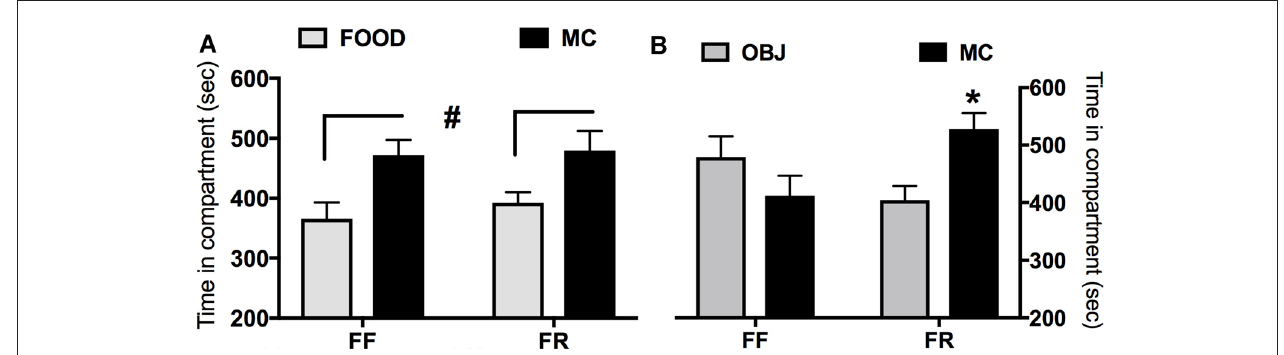
FIGURE 4 | Effects of restricted feeding (FR) on conditioned preference (seconds spent in compartment ± SEM) for a context paired with milk chocolate (MC) in different experimental conditions. (A) Preference for the MC-paired compartment vs. the compartment paired with habitual lab chow (FOOD); (B) preference for MC-paired compartment vs. the compartment paired with novel inedible objects (OBJ). # Main effect of the compartment ( p < 0.05; see text for details). ∗ Significantly different ( p < 0.05) from time spent in the alternative